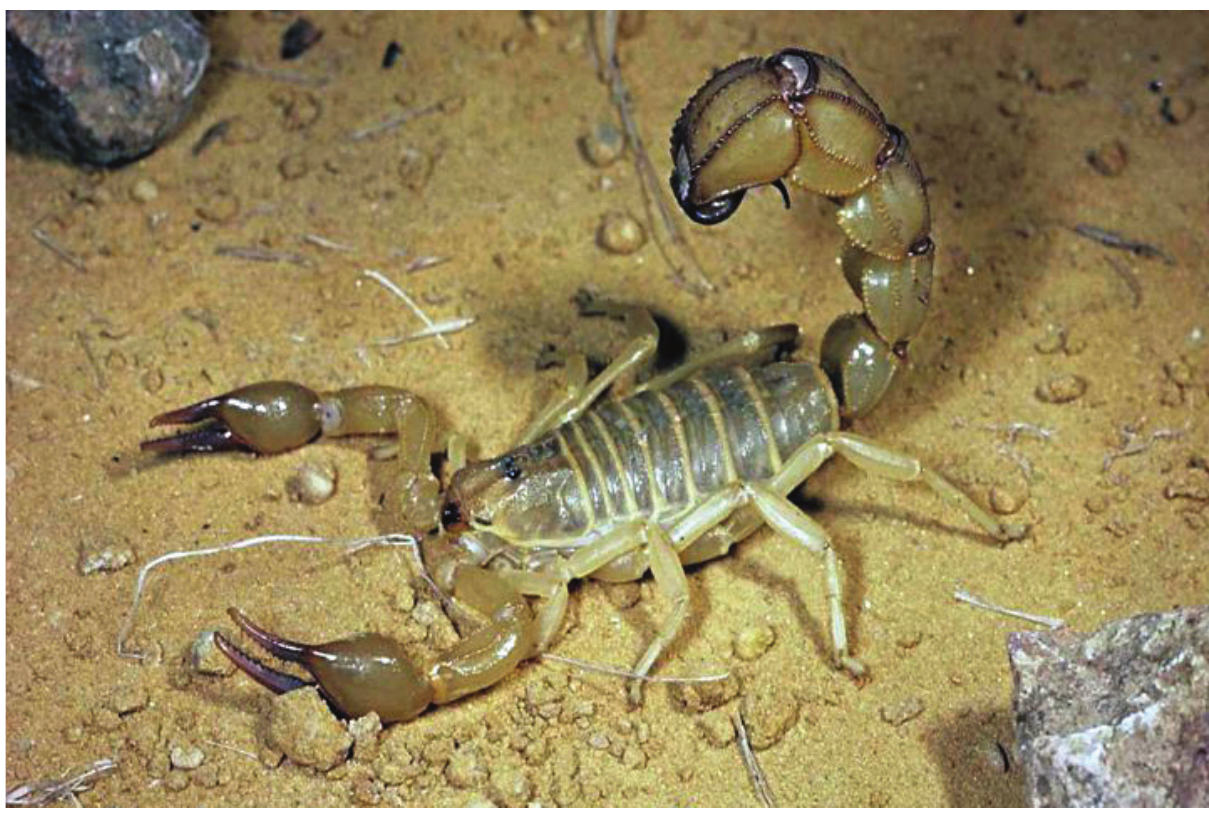
Figure 5. Androctonus australis , a very dangerous scorpion species, described for the first time in Mali (Gao district). This species requires a minimal hygrometry, and its presence is very likely along the river Niger towards other countries